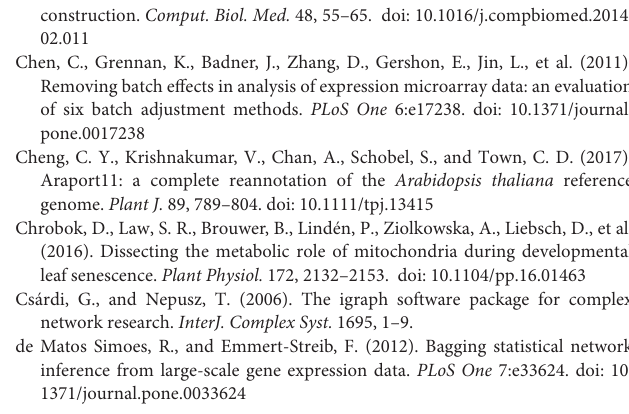
TABLE S2 | (i) Non-CSE Pearson correlation; (ii) non-CSE partial correlation; (iii) CSE Pearson correlation; (iv) CSE partial correlation. TABLE S3 | Statistics supporting Figure 3 . Table of the expected, observed, ratios, and associated P -values. This is carried out for interactions within Complex I, within and between the five Complexes of the mETC, and between the mETC and the rest of the mitochondrion. TABLE S4 | List of source and target genes comprising genes encoding proteins targeted to the mitochondrion, with unknown functions (as per MapMan X4 annotations) and their edges with known mitochondrial genes. TABLE S5 | Table of the 27 communities generated using the Walktrap algorithm on the whole AtGenExpress Set that has been centralized. TABLE S6 | Comparison of the number of edges observed within the mETC and within the functional categories (WFC) 1-27 using different approaches, with or without CSE. Six methods were included: Pearson correlation, partial correlation, WGCNA, WGCNA Consensus network, BC3Net, and GeneNet; and these were utilized on either non-centralized data (non-CSE) or centralized data (CSE). All networks were fixed to a similar sparsity, each with approximately 2400 edges (0.5%). The number of edges observed for the different approaches and data were compared to the number of edges expected by chance within the mETC and WTC. Here, blue numerals indicate that the observed number was significantly larger ( p < 0.05) than expected by chance. For each approach, the performance applying centralized versus non-centralized data were tested. Here, an ∗ indicates that significantly more edges ( p < 0.05) were observed when using CSE adjusted data. Finally, the results obtained using Pearson correlation and centralized data (PeCSE) were compared to all other methods. Approaches with significantly fewer ( p < 0.05) number of edges than PeCSE were marked with a minus sign ‘ −